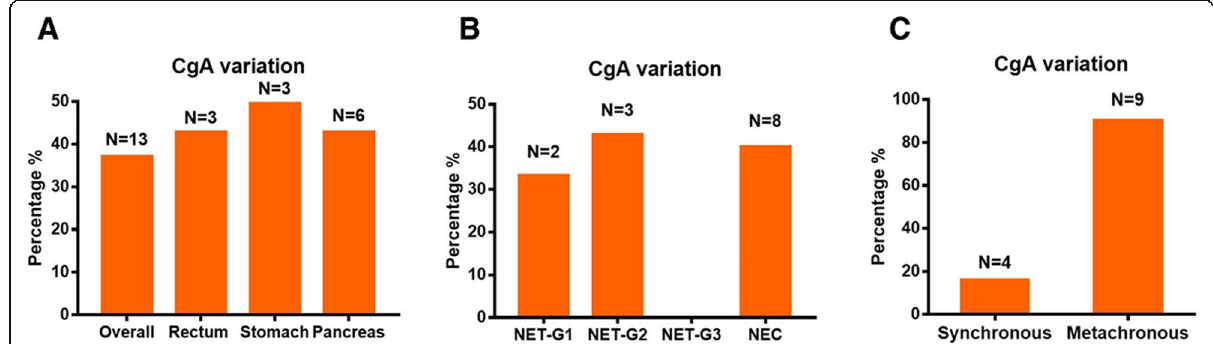
Fig. 2 Percentages of patients with CgA-variation at different primary tumor sites ( a ). Percentages of patients with CgA-variation under different classifications of NENs ( b ). Percentages of patients with CgA-variation under different types of metastatic tumors ( c )